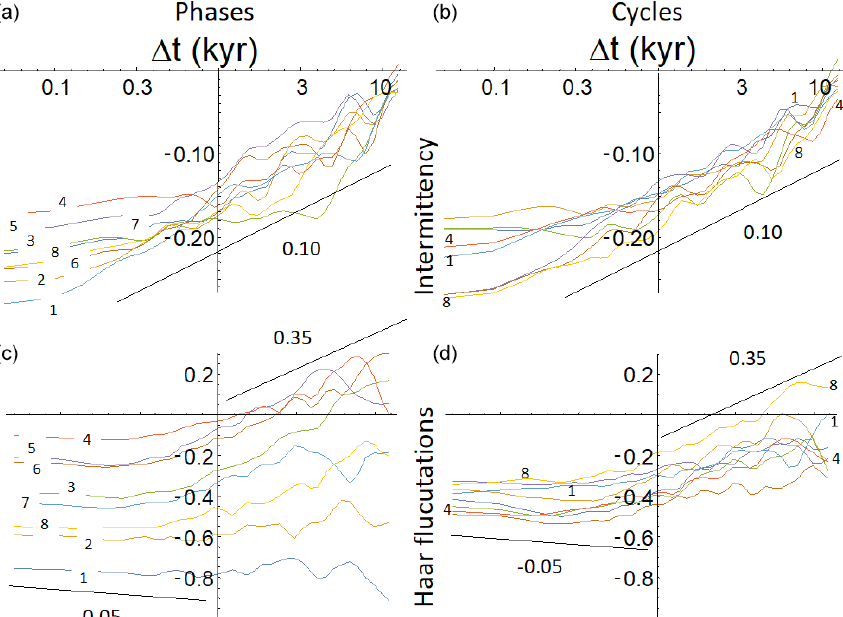
Figure 9. Panels (a, b) show the intermittency function G ( (cid:49)t ) (whose slope on the log–log plot is C 1 ), and panels (c, d) show the mean absolute Haar fluctuation S 1 ( (cid:49)t ) (whose slope on the log–log plot is H ); (a, c) show the result for each phase after averaging over the eight cycles with the numbers next to each line indicate the phase number (each colour corresponds to the same number); (b, d) show the result for each cycle after averaging over the phases. Here, the same colours and numbers correspond to the cycle number; shown are only cycles 1, 4, and 8 to avoid clutter. Whereas each cycle is fairly similar to every other cycle (the b, d ), each phase is quite different (a, c) . We see that the most significant difference is the fluctuation amplitude as a function of phase (c)